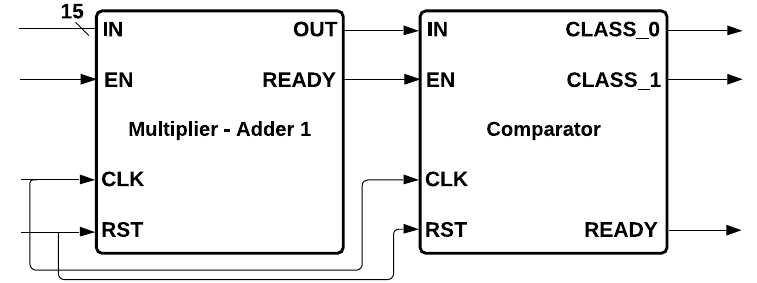
Figure 12. Support Vector Machine Hardware